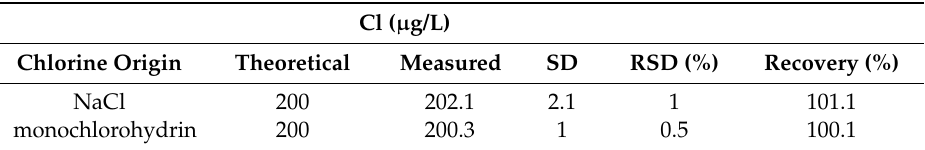
Table 2. Accuracy and precision of 35 Cl (originating from inorganic and organic compounds) determination (SD—standard deviation; RSD—relative standard deviation)